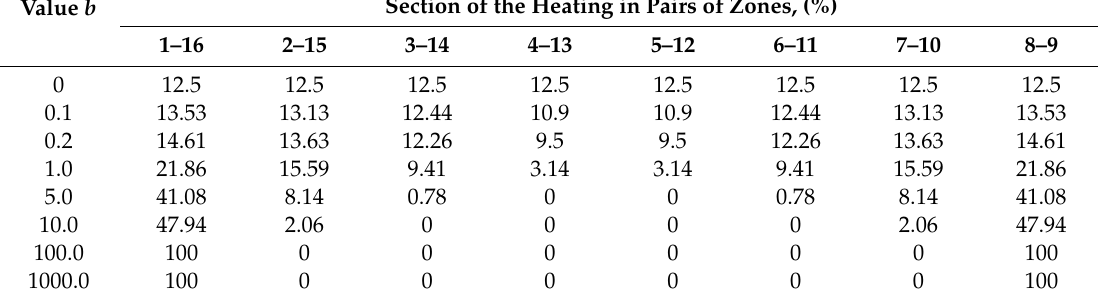
Table 4. Distribution of the mass flow rate of furnace gas streams in pairs of furnace zones depending on the small-scale circulation exponent b . Distribution of the Mass Flow Rate of Furnace Gases Recirculating through the Middle Section of the Heating in Pairs of Zones, (%) Value b